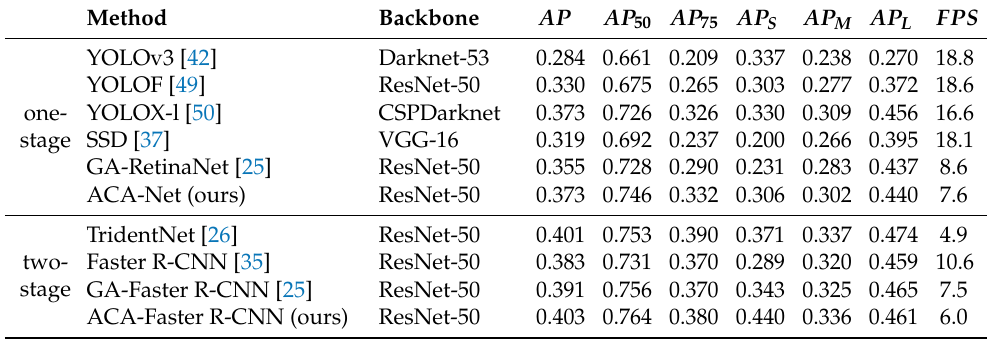
Table 3. Comparison